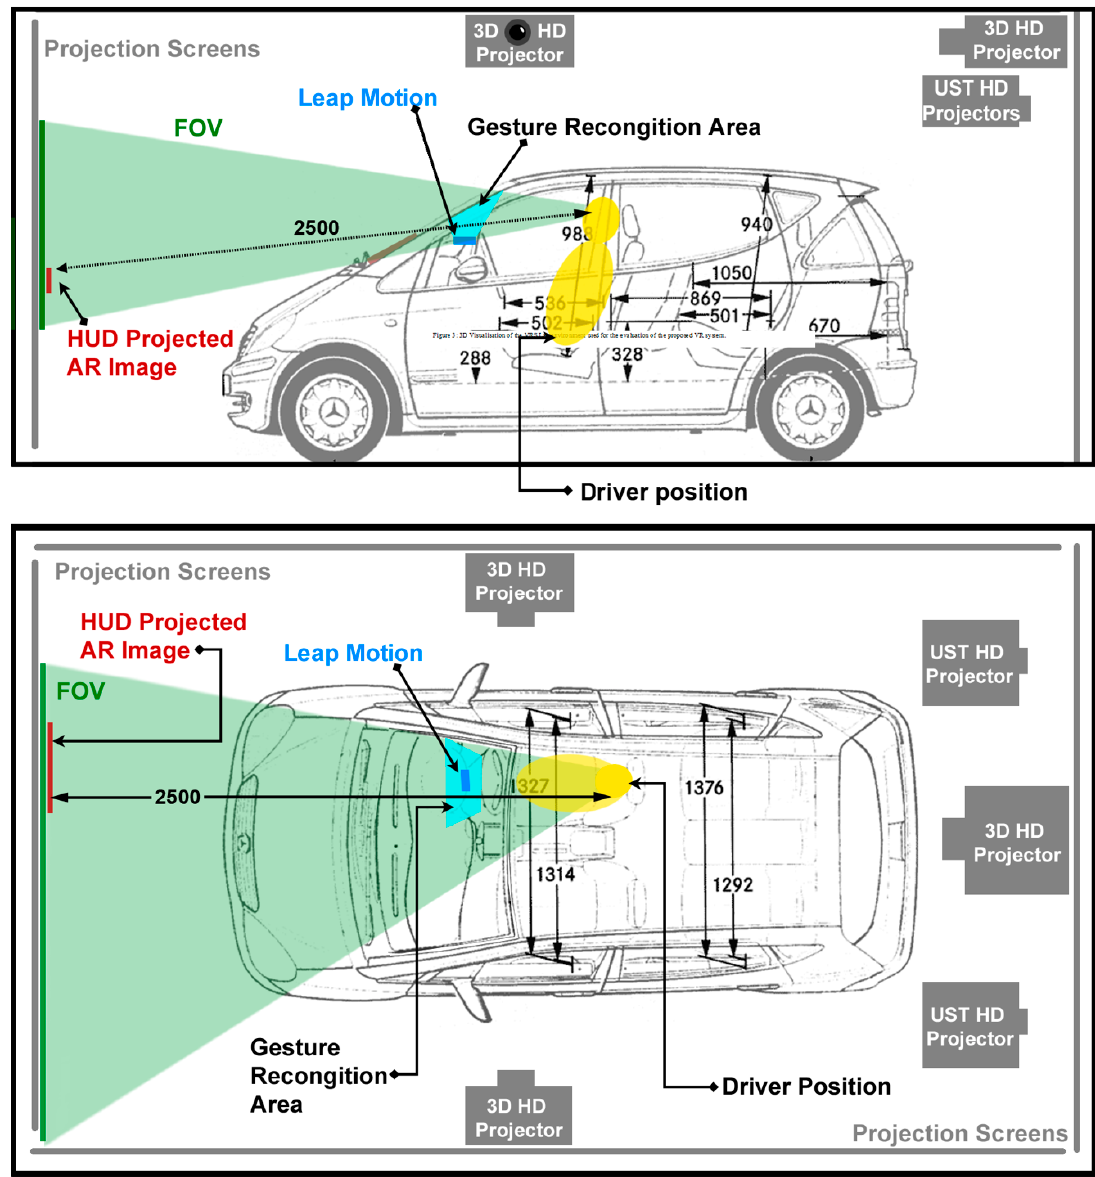
Figure 7. Explanatory image of the VR driving simulator laboratory (VRDS Lab) set up. The vehicle interior accommodated the HDD in the form of a lower touchscreen (smart tablet) positioned in the existing screen-space that the manufacturer has provided for such systems which are located in the middle section of the dashboard in relatively close proximity to the user’s extended arm and approximately 720–880 mm from the driver’s eyes [14,23]. Evaluation of multiple potential positions has been performed in-depth and results indicate that the following order, F, C, A, D, B, G, and E are the best to worst options as illustrated in Figure 8 [46]. The selected HDD position, the upper part of the cluster/dash- board (C), used in this experiment, is the second-best position following the HUD pro- jected in front to the driver’s field of view (FOV) [46]. Notably, any other HDD position results in worse results for the HDD users as presented in previous studies [46–48]. In particular, this work compares the best possible HDD position (C) against the proposed HUD (F) which occupies a typical HUD space in the windscreen and appears to be em- bedded in the environment.